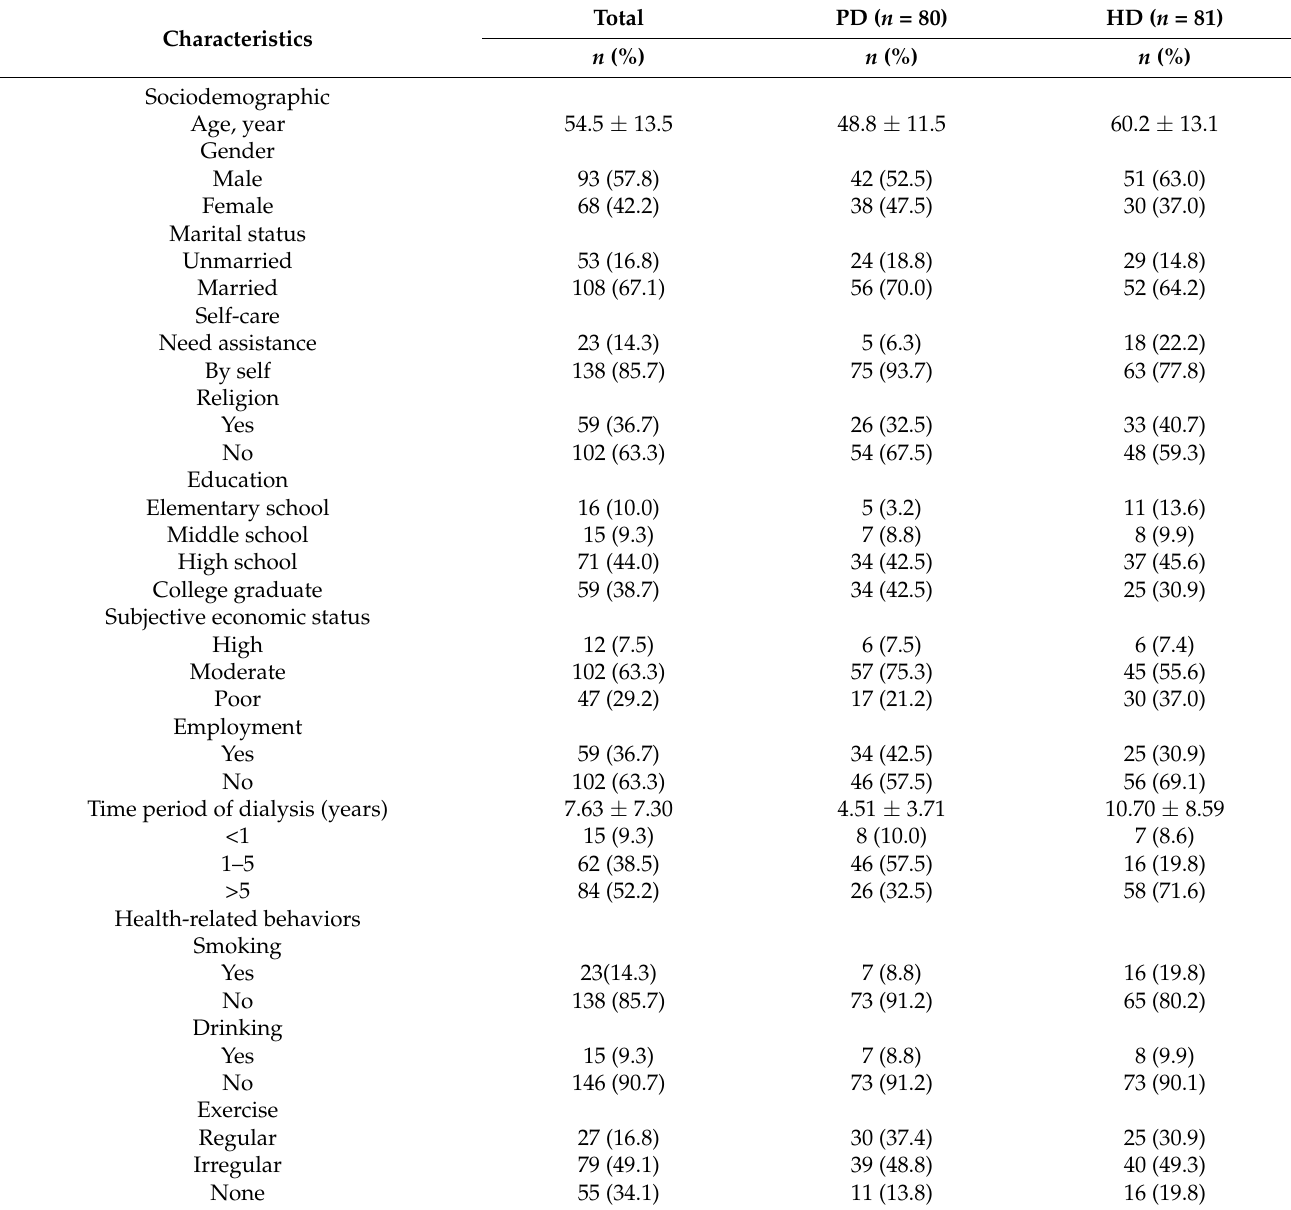
Table 1. General characteristics of participants ( n =